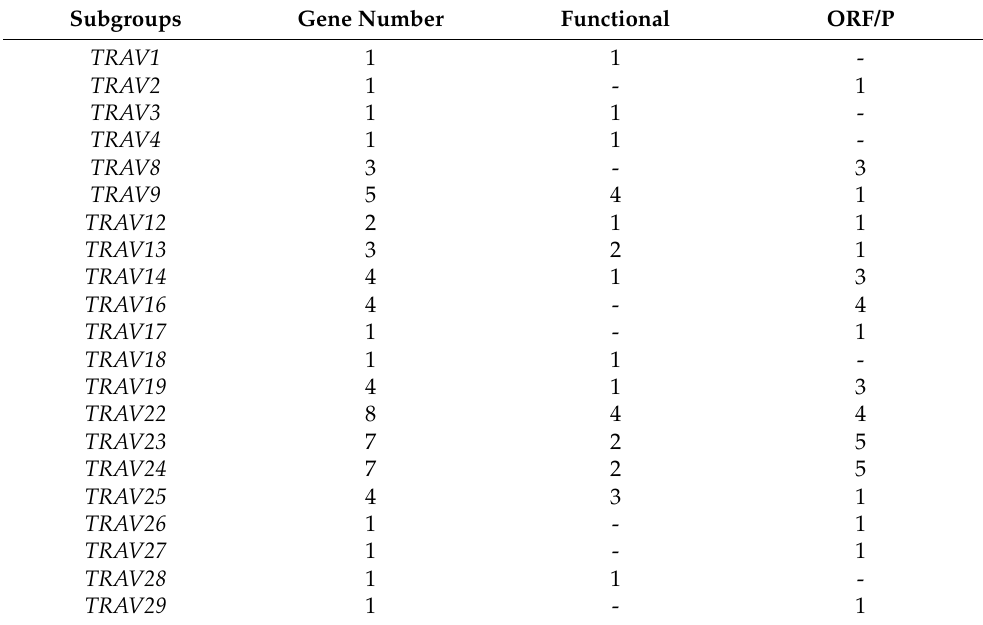
Figure 1. Schematic representation of the genomic organisation of the dromedary TRA/TRD locus deduced from the genome assembly CamDro3. The diagram shows the position of all related and unrelated TRA and TRD genes according to nomenclature. The boxes representing the genes are not to scale. The exons are not shown. The arrows indicate the transcriptional orientation of the genes. Table 1. Description of the TRAV